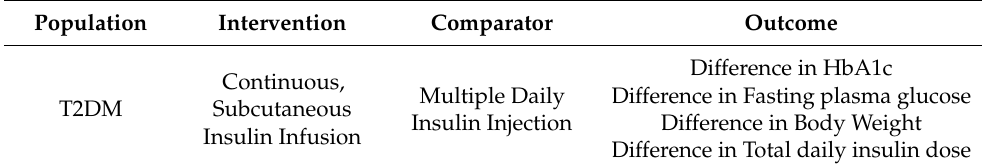
Table 2. Inclusion criteria of the present study.